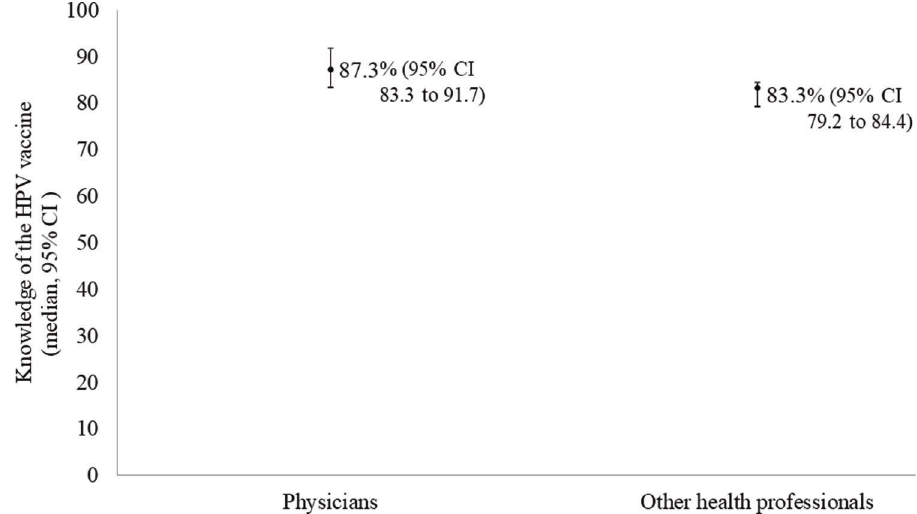
Figure 1 - General knowledge of the HPV vaccine among physicians and other health professionals interviewed in the Health Care System for Women and Children (SASMC) in the state of Acre, Brazil, in 2017. Interquartile regression*: b =-4.2 (95% CI -13.7 para 5.3); p =0.10 *Adjusted by sex, stable union, age, and